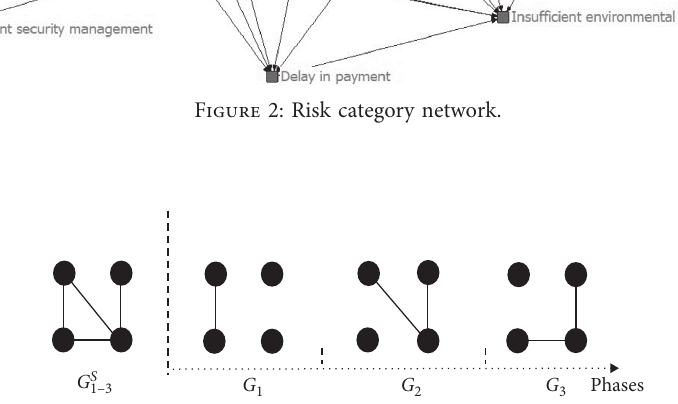
Figure 3: Comparison between aggregation graph representation and dynamic sequence